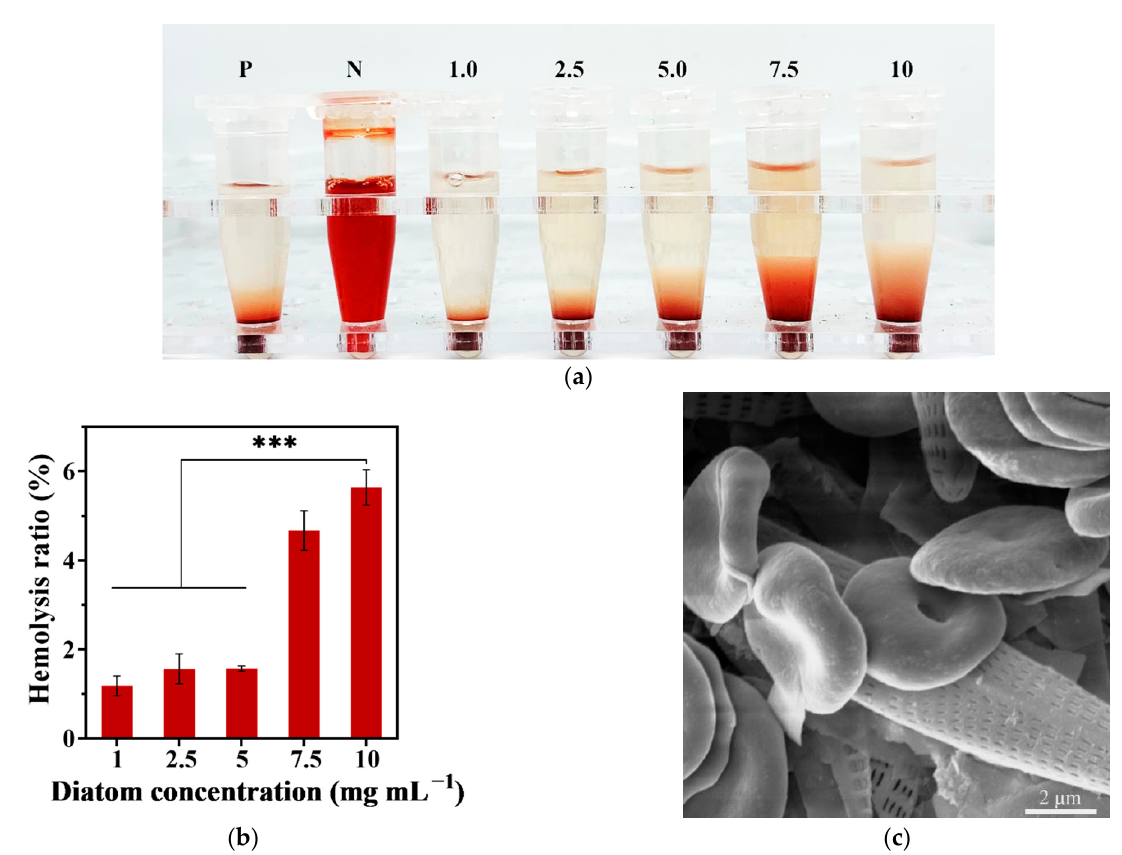
Figure 3. ( a ) Photographs of red blood cells (RBCs) treated with different concentrations of diatom frustules (mg mL − 1 ); P refers to positive control, N refers to negative control. ( b ) Hemolysis ratio of different concentrations of diatom frustules in saline suspension. ( c ) Scanning electronic microscopy (SEM) image of red blood cells after hemolysis test with 2.5 mg mL − 1 diatom frustules. Data represent the mean ± SD (n = 3). *** represents a significant difference, p < 0.001.